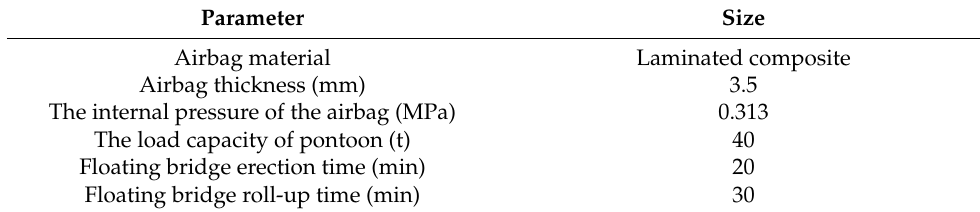
Table 3. Main technical parameters and indicators of the floating